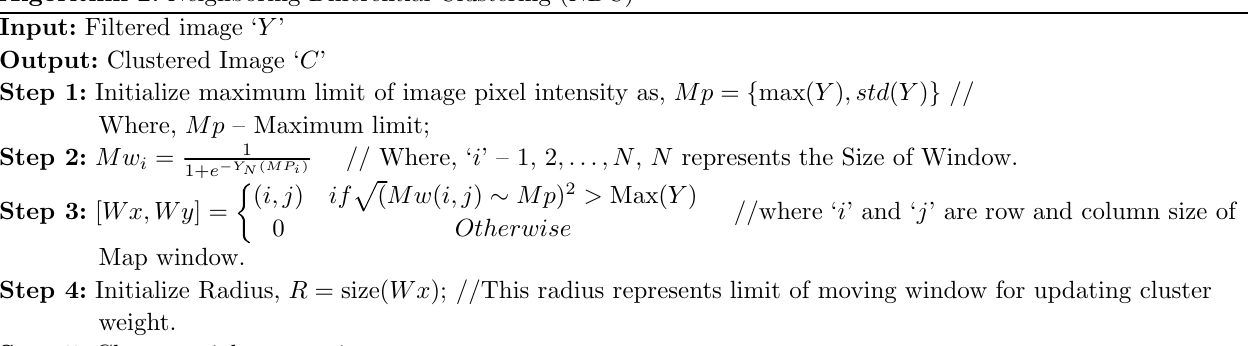
Algorithm 2. Neighboring Differential Clustering